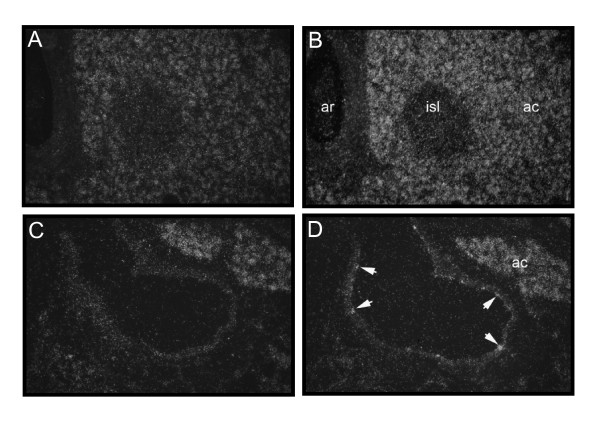
EpoR probe validation in human pancreatic tissue. A, A section of human pancreatic tissue with sense RNA probes for EpoR. B, Same tissue with anti-sense RNA probes for EpoR, demonstrating increased expression in islet of Langerhans cells. C, A section of human pancreatic tissue showing a vein adjacent to an acinar cell, with sense RNA probes. D, The same tissue with anti-sense RNA probes for EpoR, demonstrating expression in the endothelium of the vein (arrows). Abbreviations: ac, acinar cells; ar, artery; isl, islet of Langerhans.